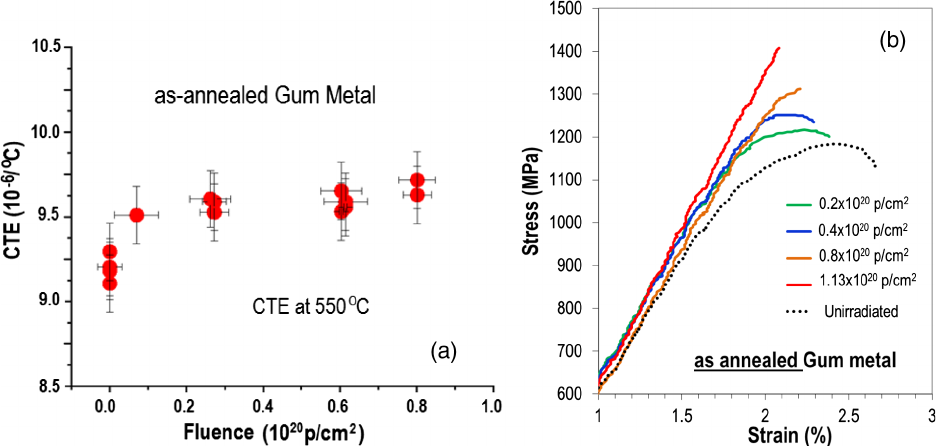
FIG. 17. Irradiation effects on (a) CTE and (b) ductility of “ annealed ” gum metal.